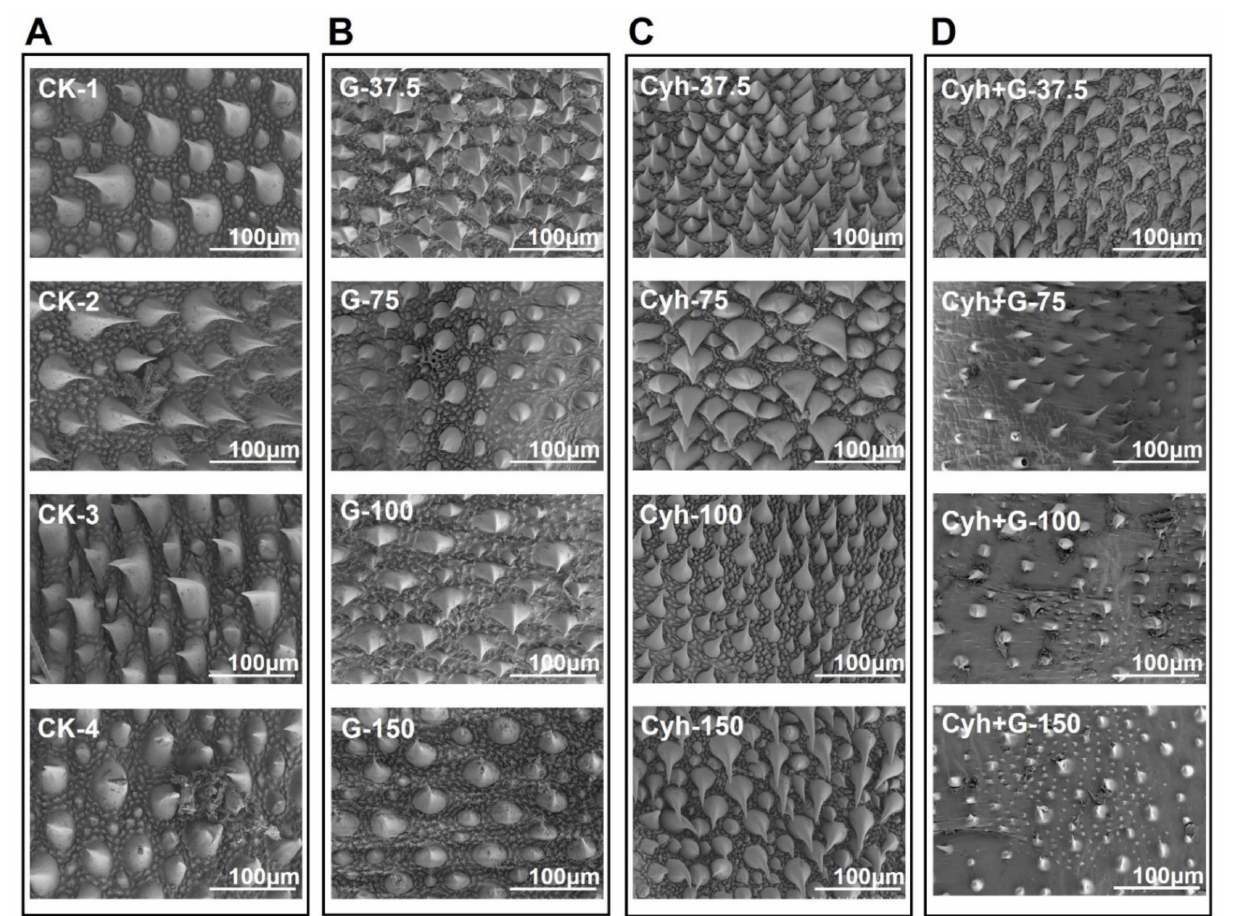
Figure 8. SEM images of the cotton bollworm epicuticle. ( A ) Control group. ( B ) Treated with graphene. ( C ) Treated with Cyh. ( D ) Treated with Cyh/G. CK represents distilled water